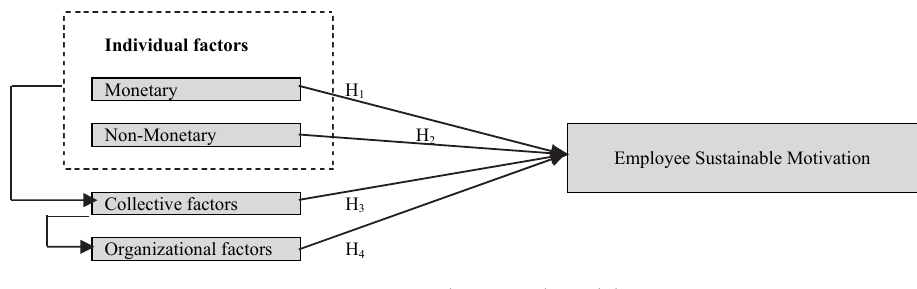
Fig. 1. The research